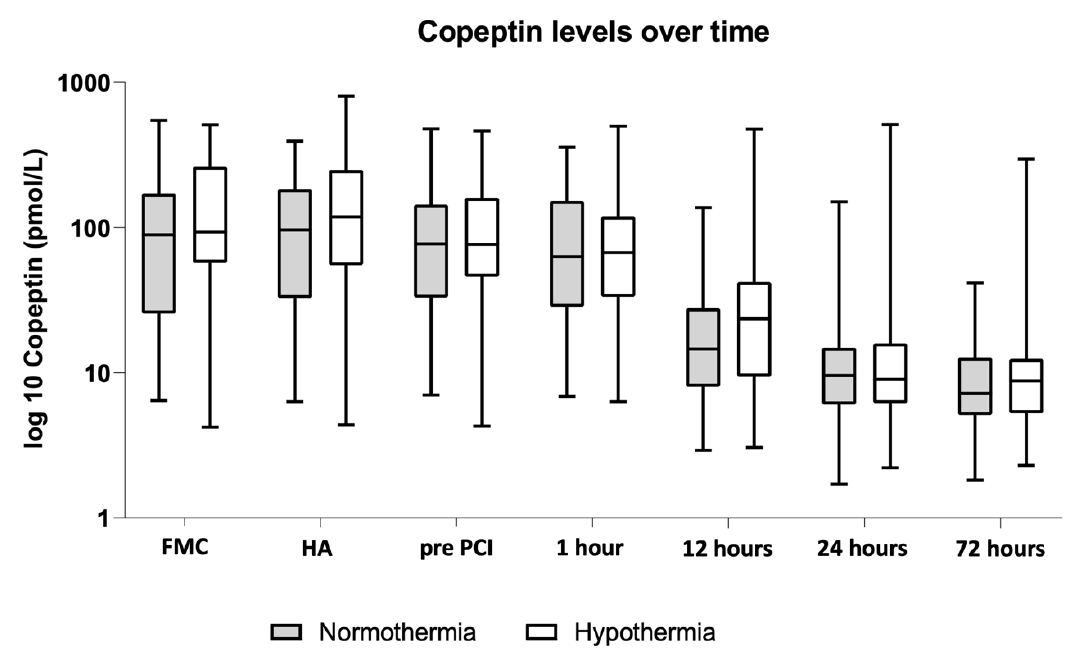
Figure 1. Copeptin levels over time. FMC: First Medical Contact; HA: Hospital Admission; pre PCI: before Percutaneous Coronary Intervention. Data are log 10 transformed. At first medical contact, no differences in copeptin values between the MTH (101.225 pmol/L (57.84–258.13 pmol/L)) and control group (89.11 pmol/L (25.6–170.9 pmol/L), p = 0.209) were found.